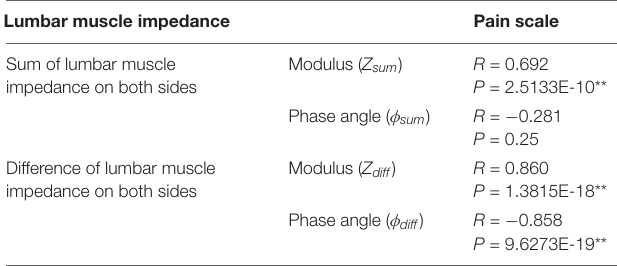
TABLE 2 | Correlation between lumbar muscle impedance and pain scale. Lumbar muscle impedance Pain